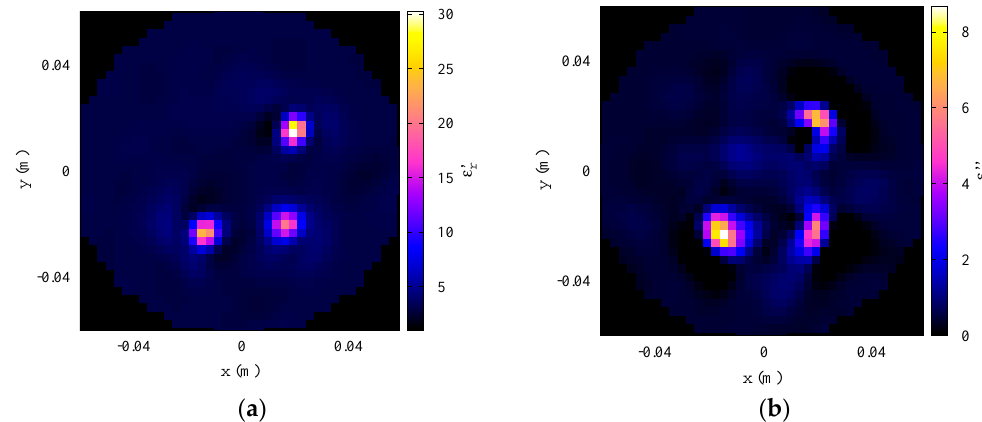
Figure 8. Experimental results. Reconstructed distributions of the ( a ) real part and ( b ) imaginary part of the complex relative dielectric permittivity at 3.8 GHz obtained with the proposed hybrid algorithm.